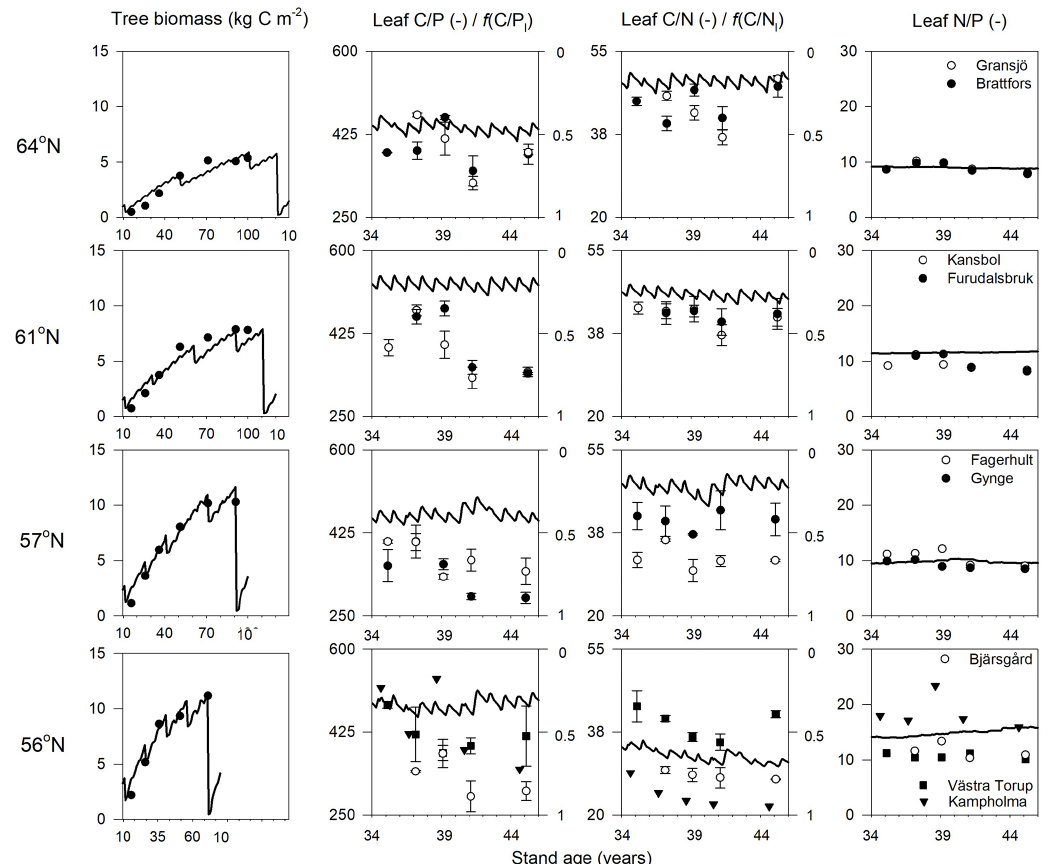
Figure 2. Simulated (lines) and measured (symbols) plant biomass and leaf C / P, C / N, and N / P ratios over the rotation period across the four regions. The x axis denotes the stand age in years. The right axis of charts showing leaf C / P and C / N ratios shows the minimum ( f (nutrient) = 0) and optimum ( f (nutrient) = 1) values in terms of nutrient response to gross primary production, respectively. Biomass data and leaf nutrient data were from SFI (SLU, 2003) and the Swedish Forest